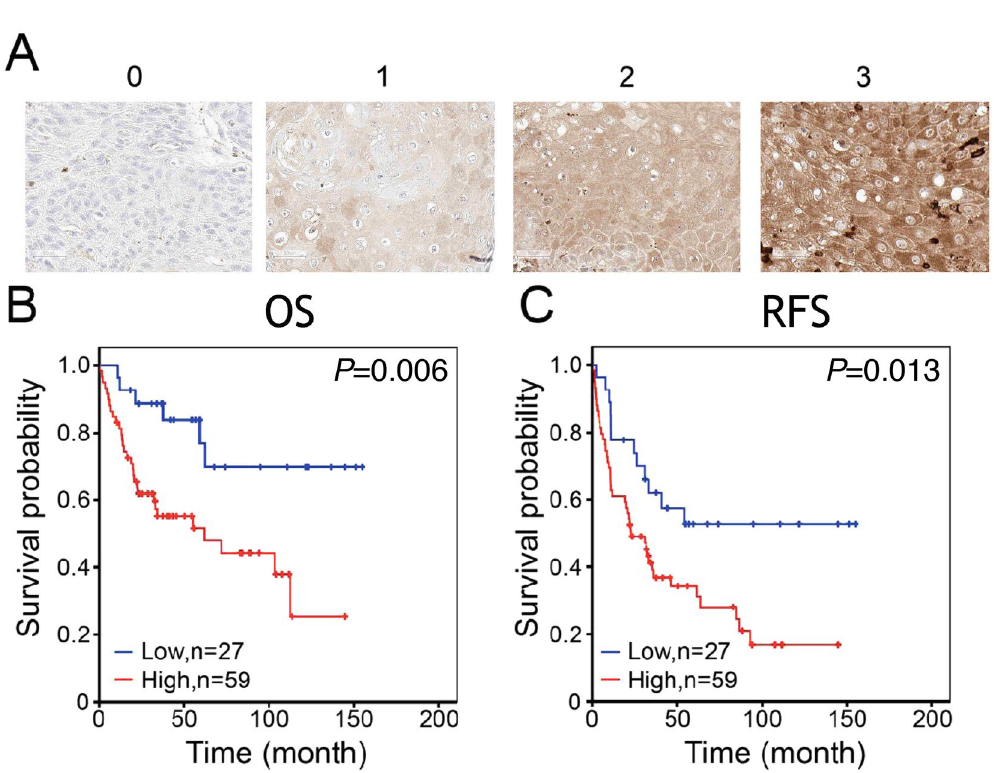
Figure 4. Higher TMSB4X IHC expression is correlated with poor prognosis in HNSCC cohort. ( A ) The representative images with different IHC intensity of TMSB4X. Scale bar represents 50 µ m. ( B , C ) Kaplan-Meier estimates of OS ( P = 0.006) and RFS ( P = 0.013) were categorized by TMSB4X level. Patients with high TMSB4X had significantly poor prognosis. Statistics was calculated by log-rank